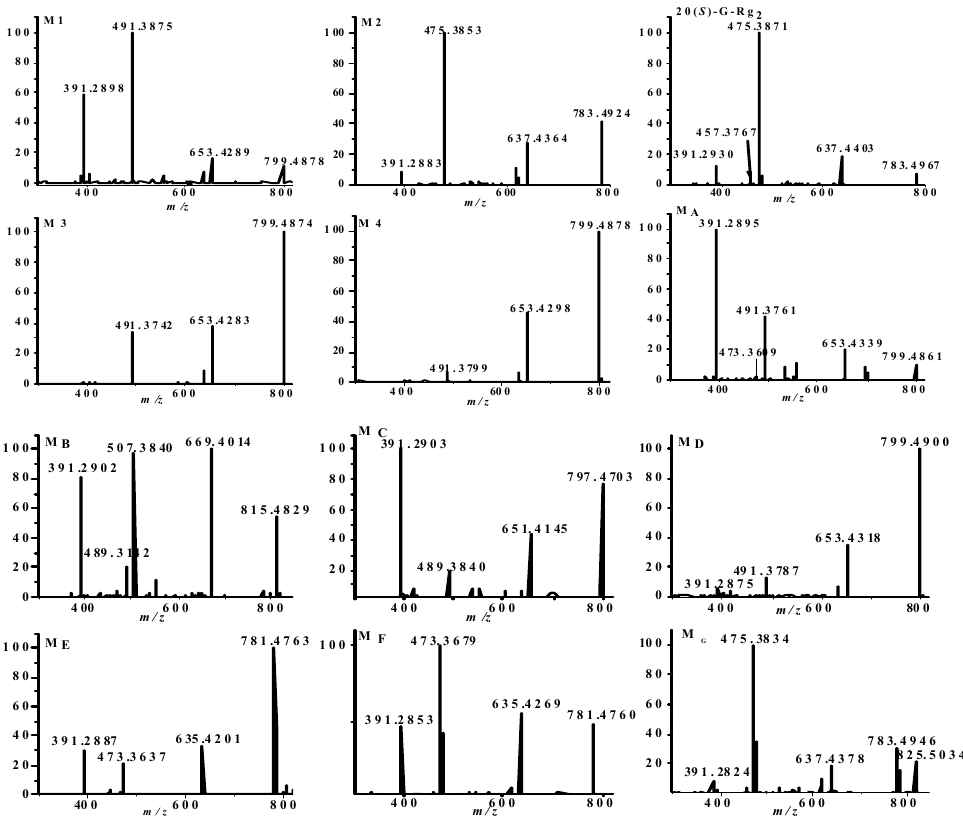
Figure 3. The MS 2 spectra of 20( S )-G-Rg 2 , M1 – M4 and M A – M G . Figure 4. The MS 2 spectra of 20( S )-G-Rg 2 , M1 – M4 and M A – M G